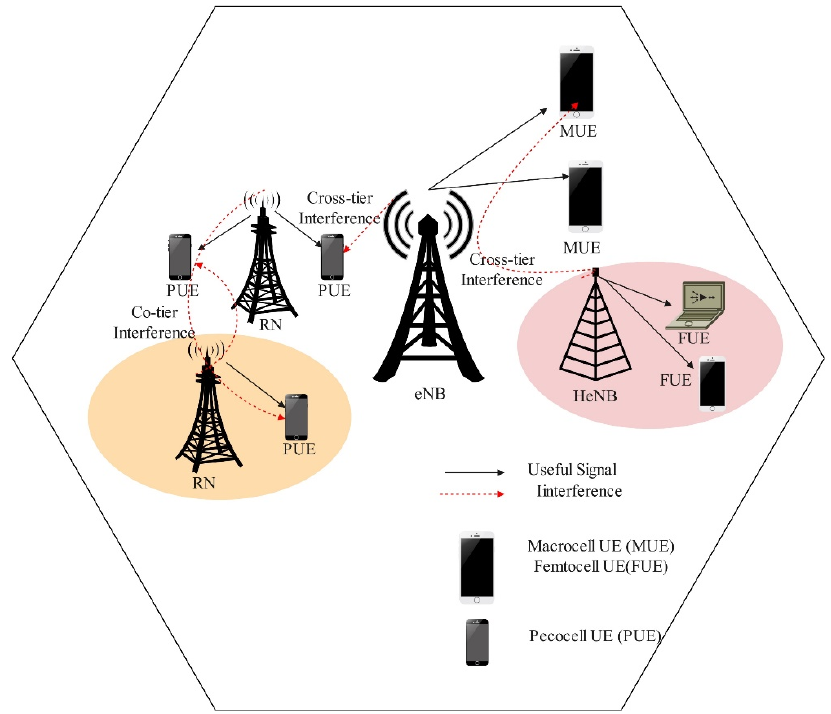
Figure 6. The interference in